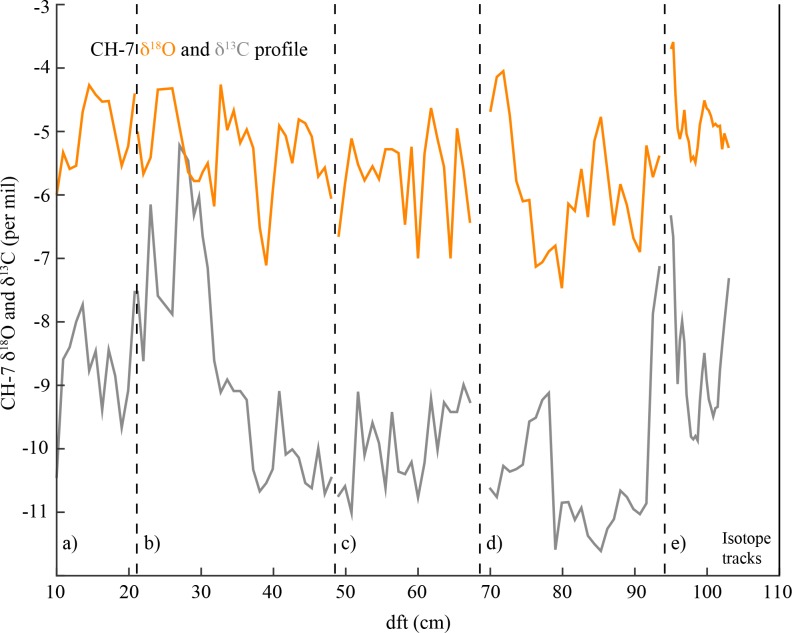
Stable isotope profile.Stable oxygen and carbon isotope profile of CH-7 (δ18O and δ13C, orange and grey curve, respectively).